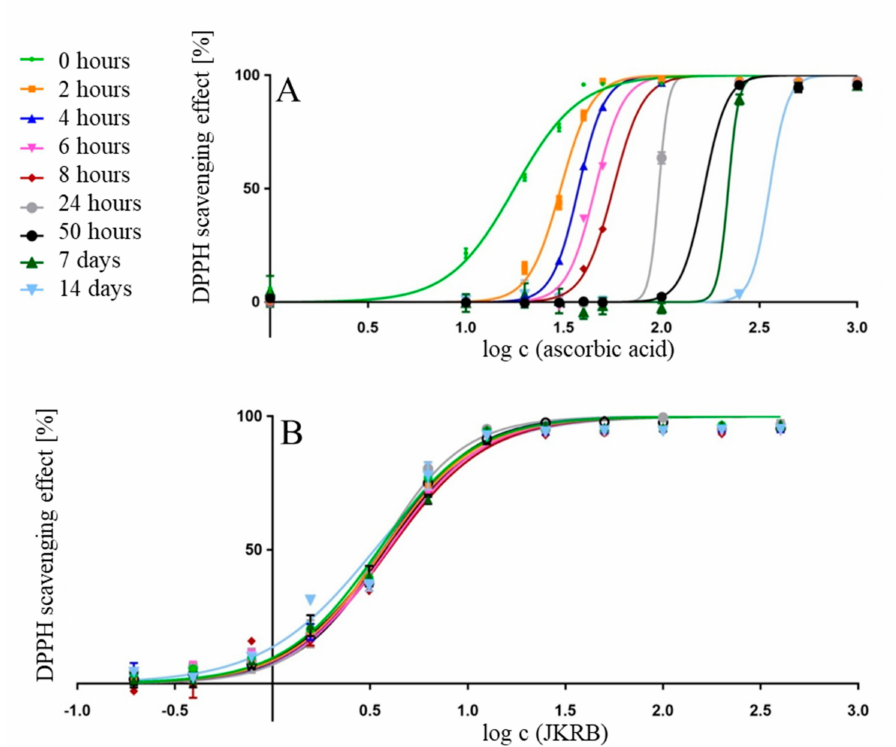
Figure 2. Logarithmic curves plotting the 2,2-diphenyl-1-picrylhydrazyl (DPPH) scavenging effect (%) of ascorbic acid ( A ) and JKRB 70% ethanol (aq) extract ( B ) against the concentration, measured over